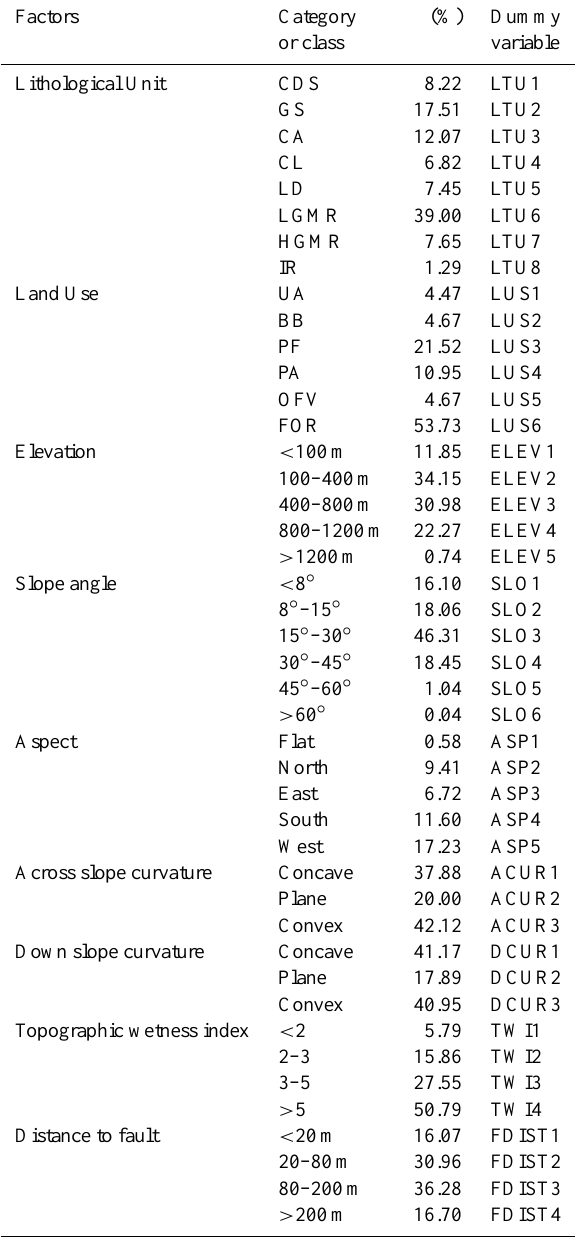
Table 1. Frequency of territorial factors categories or classes and relative dummy